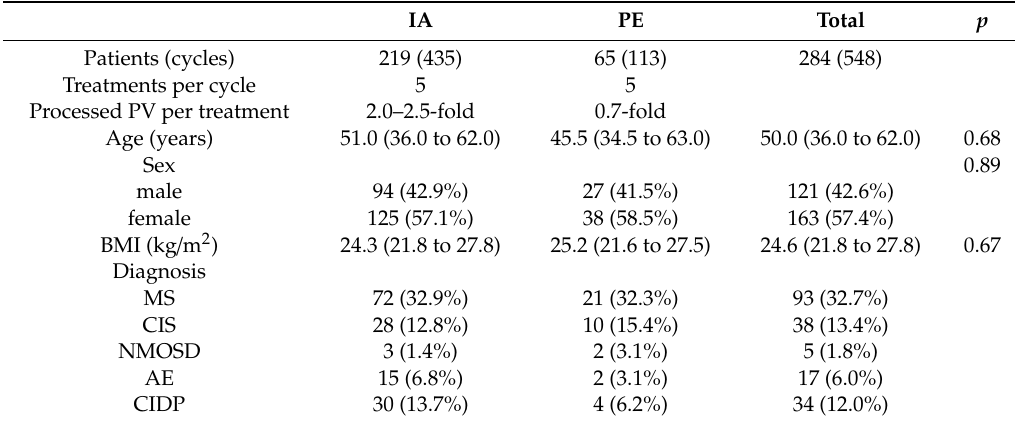
Table 1. Baseline